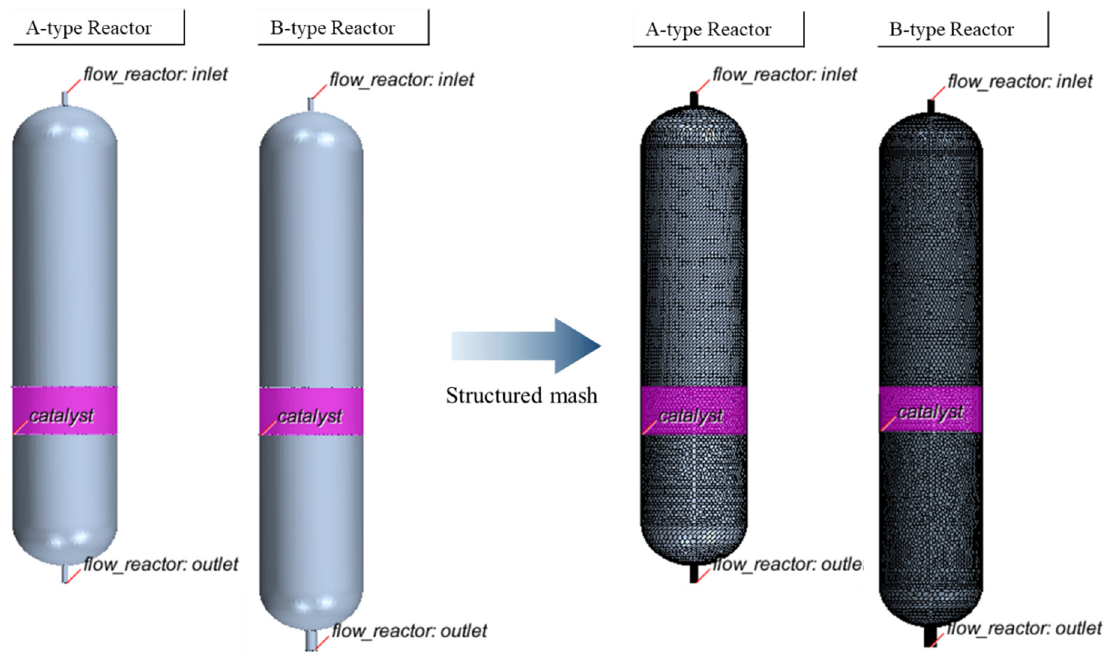
Figure 13. Computational domain and mesh generation of the two types of CO 2 methanation reactors. Table 4. Mesh constitution of reactor type.